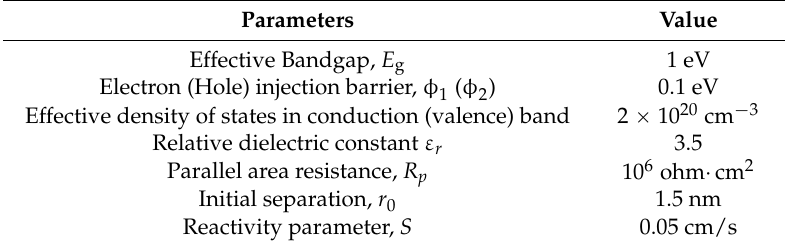
Table 1. Parameters used for calculating characteristics of P3HT:PC 61 BM BHJ organic solar cells.